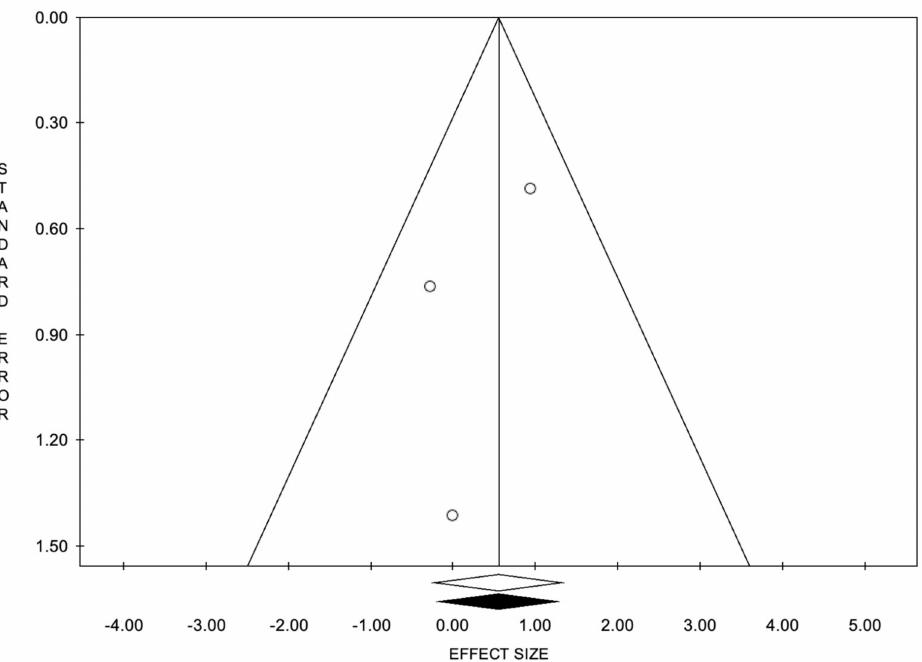
Figure 7. Funnel plots of the meta-analysis evaluating the event rate for Overall Response Rate. Egger’s linear regression (t = − 0.98, p = 0.505) and Begg and Mazumdar’s rank correlation test (z = − 0.52, p =